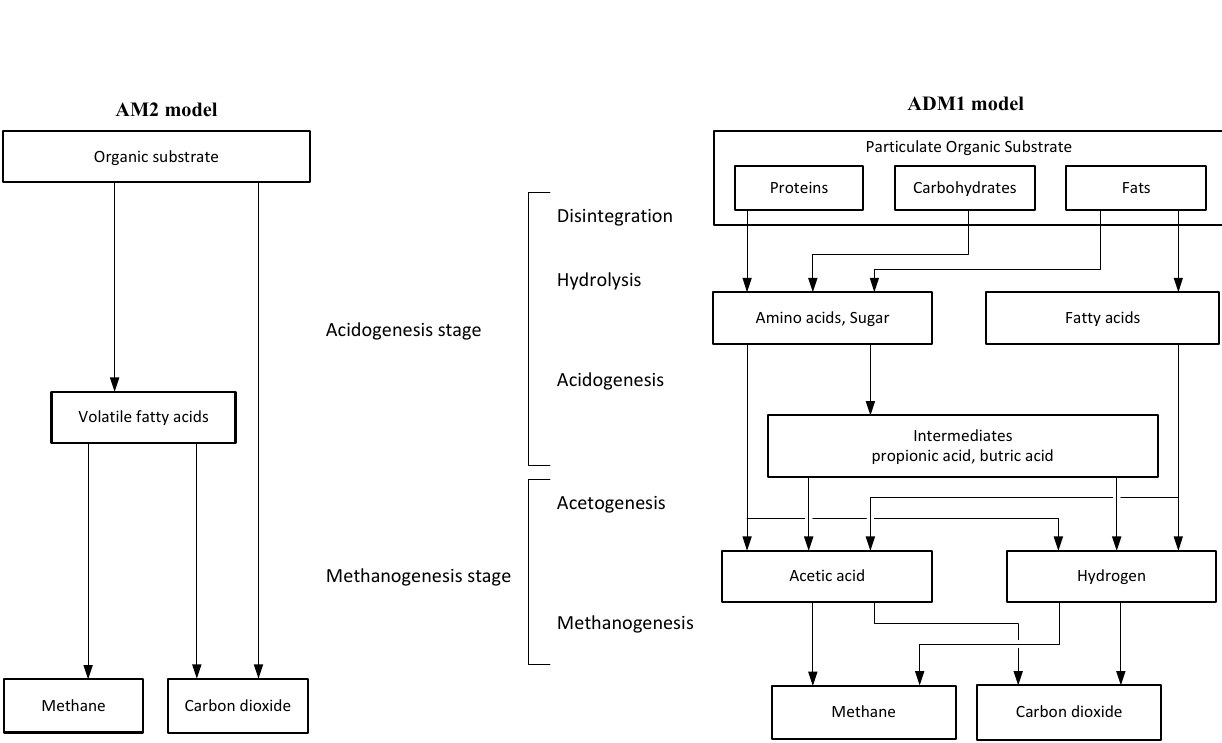
Figure 1: Comparison between ADM1 and AM2